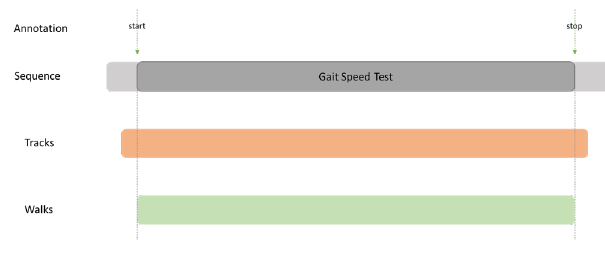
Figure 1. Relationship between a recorded sequence, the annotation and the tracked walks. The sequence contains all recorded tests. The manual annotation labels starting and endpoint.